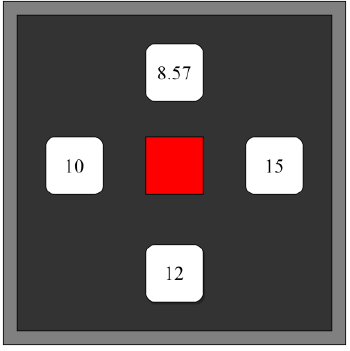
Figure 1. The distribution of the four stimulus targets on the graphical user interface is shown. Each stimulus target has a different frequency.